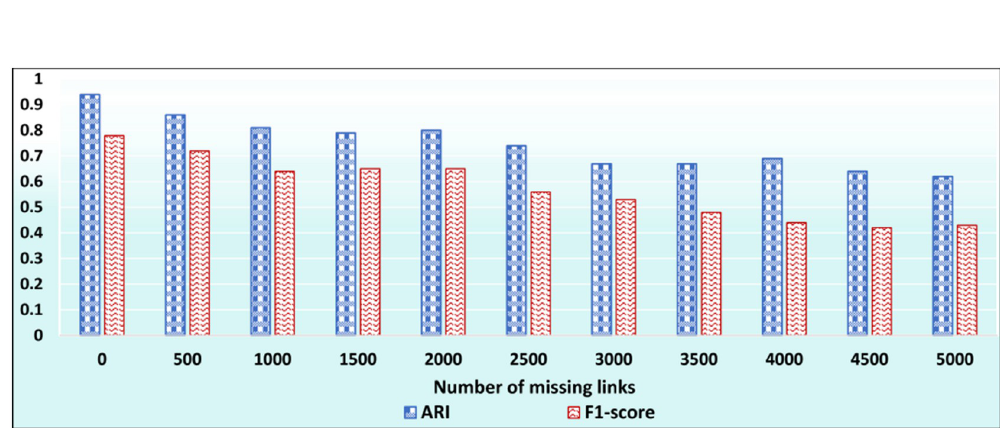
Fig 34. The accuracy of ID_CC in detecting the Facebook Social Circles communities after reinstating the missing Association Edges.